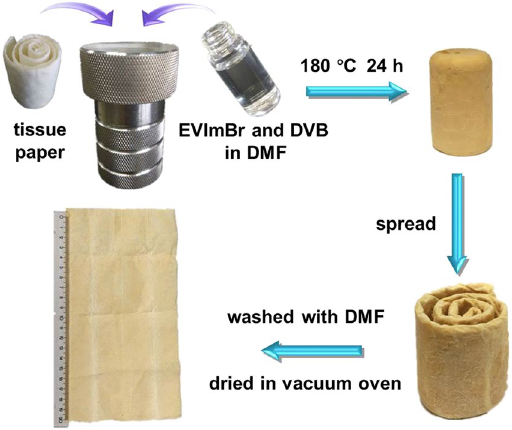
Figure 1. The schematic illustration of the preparation of PPHMs via solvothermal copolymerization of EVImBr and DVB in DMF in the presence of tissue paper in an